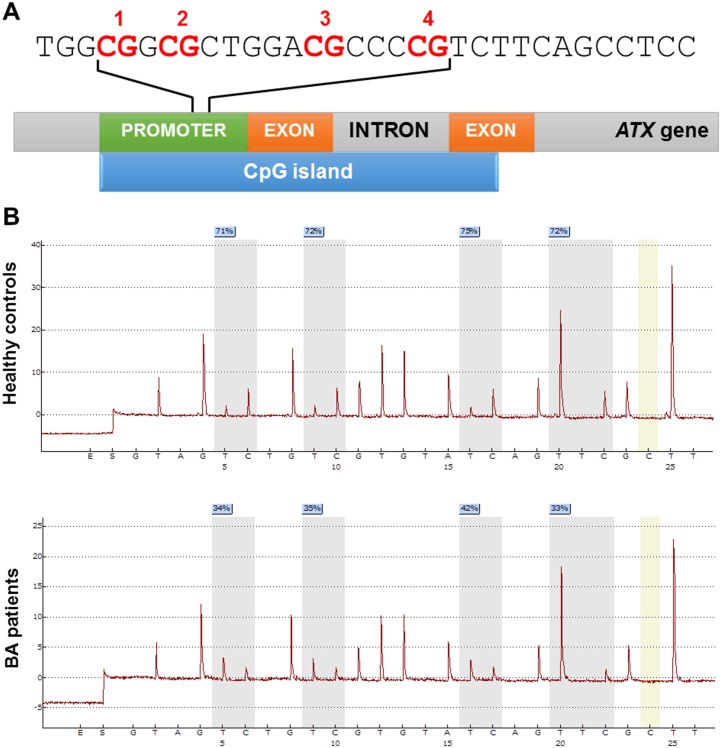
DNA methylation at four CpG islands within ATX gene promoter.(A) Schematic diagram representing CpG islands at the ATX promoter showing the four CpG sites. (B) Pyrosequencing results in healthy controls and BA patients.